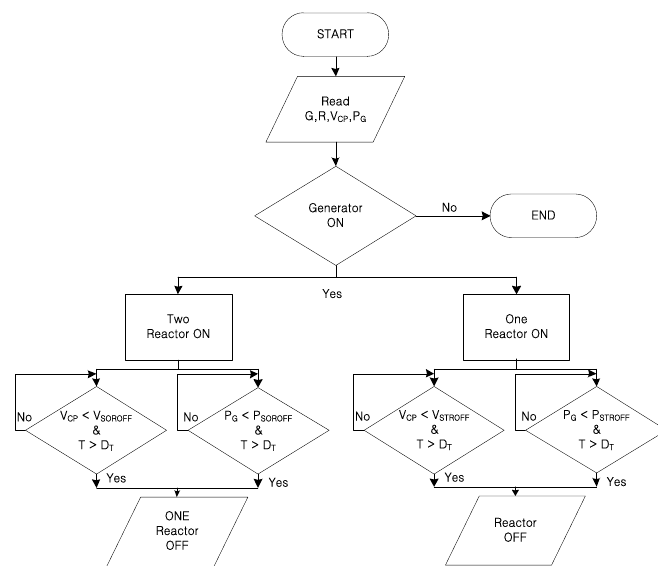
Figure 8. Flow chart for ON operation of reactors.